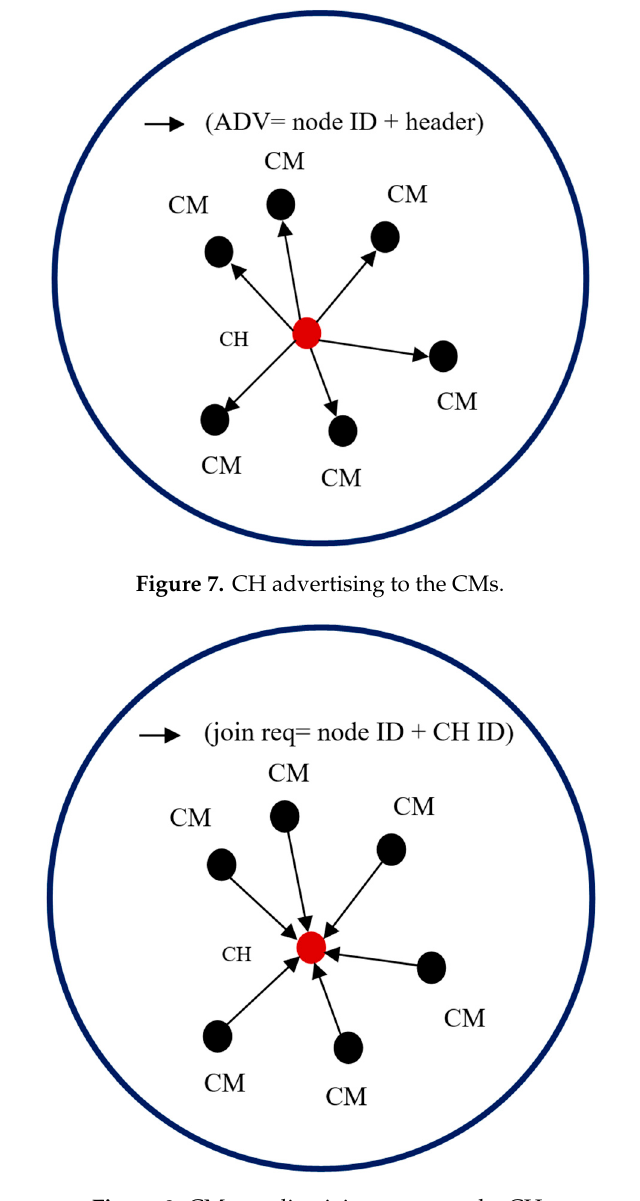
Figure 6. Overlapped FoVs of sensor nodes in a network area.